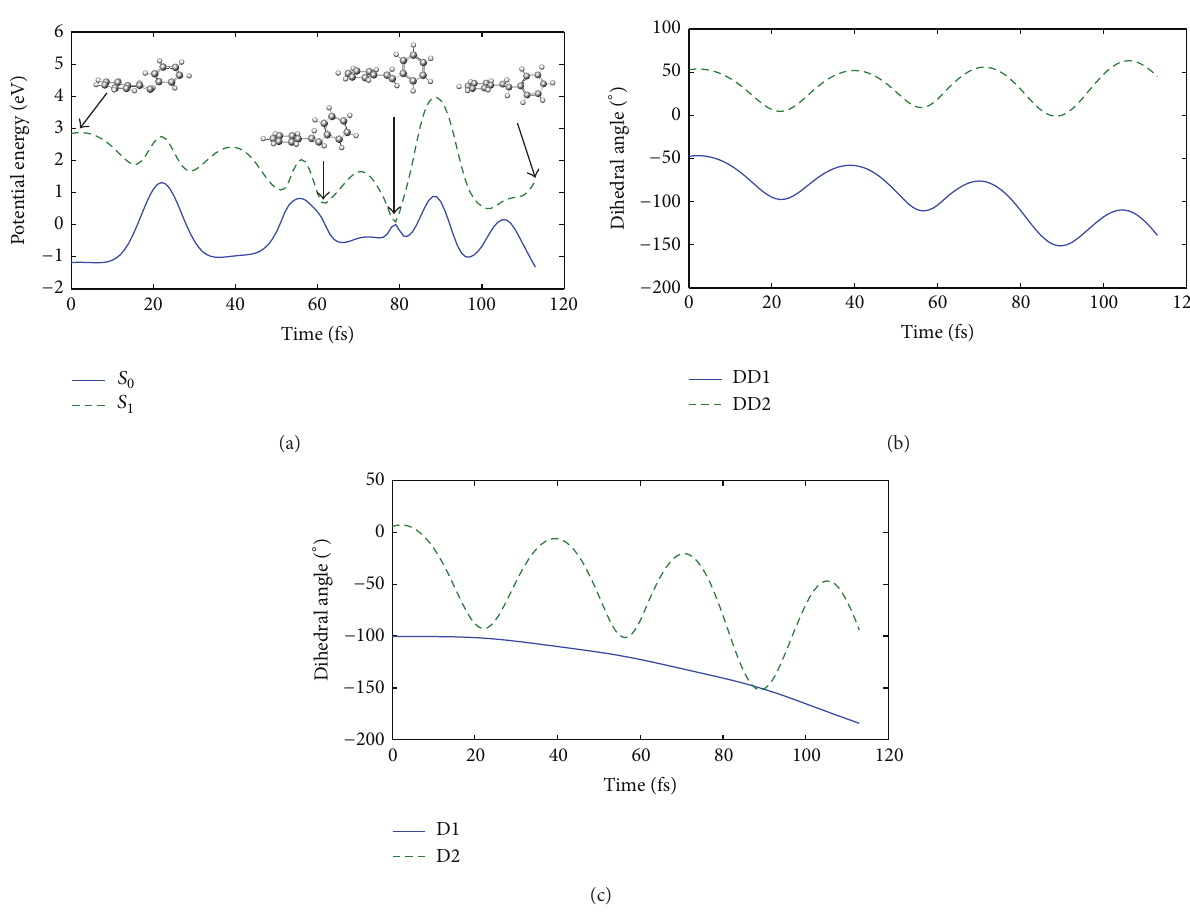
Figure 4: A typical reactive trajectory for cis-to-trans isomerization starts from local cis-area with photo-excitation energy 4.42 eV. (a) Snapshots of potential energy surfaces and structures varying with time, (b) DD1 and DD2, and (c) D1 and D2 varying with